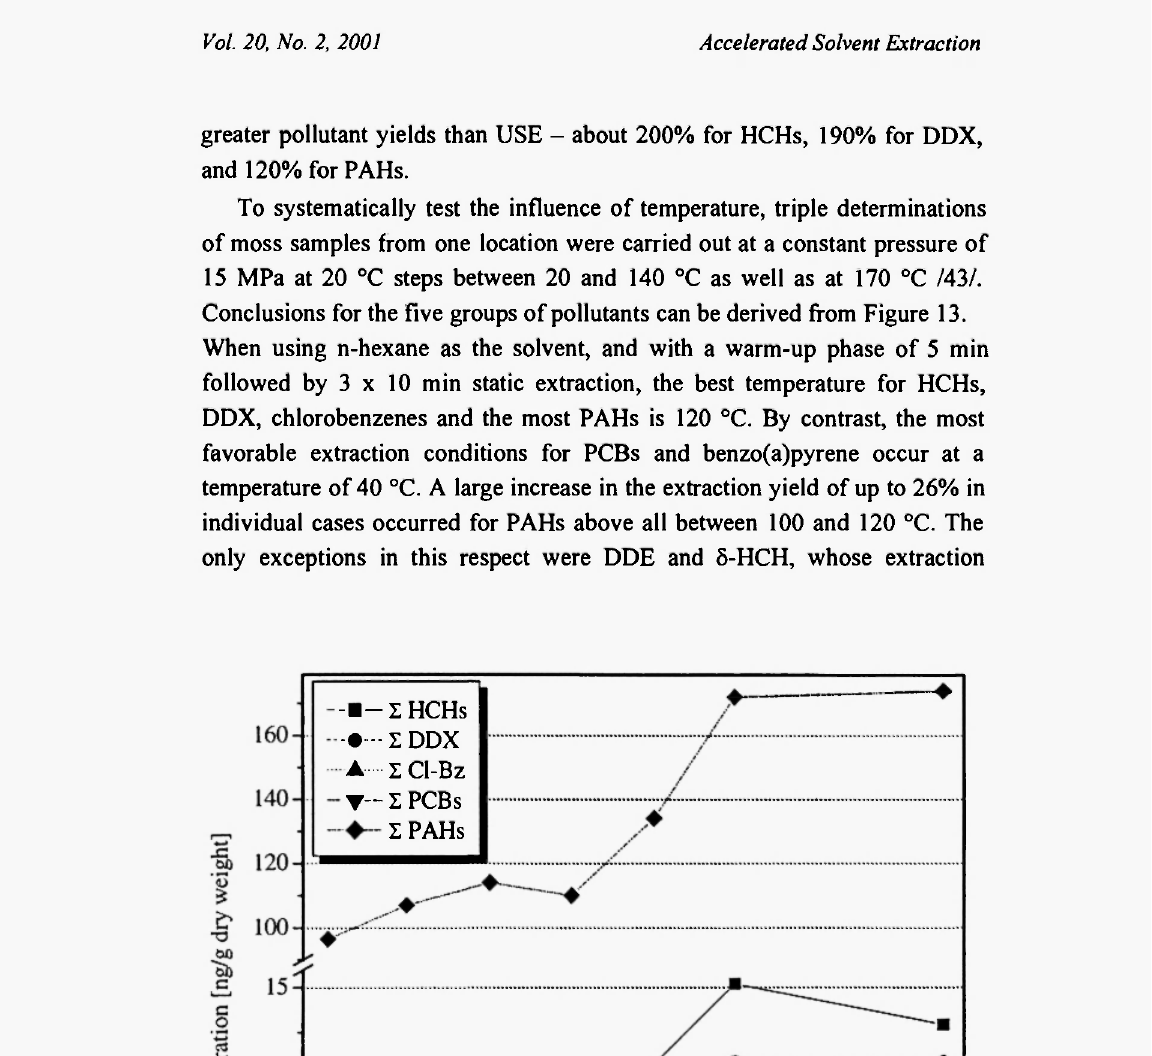
Temperature [°C] Fig. 13: Sum Curves for Extraction efficiency of different pollutant groups from mosses ( Pleurozium schreberi) in dependence on the extraction temperature using ASE (solvent is